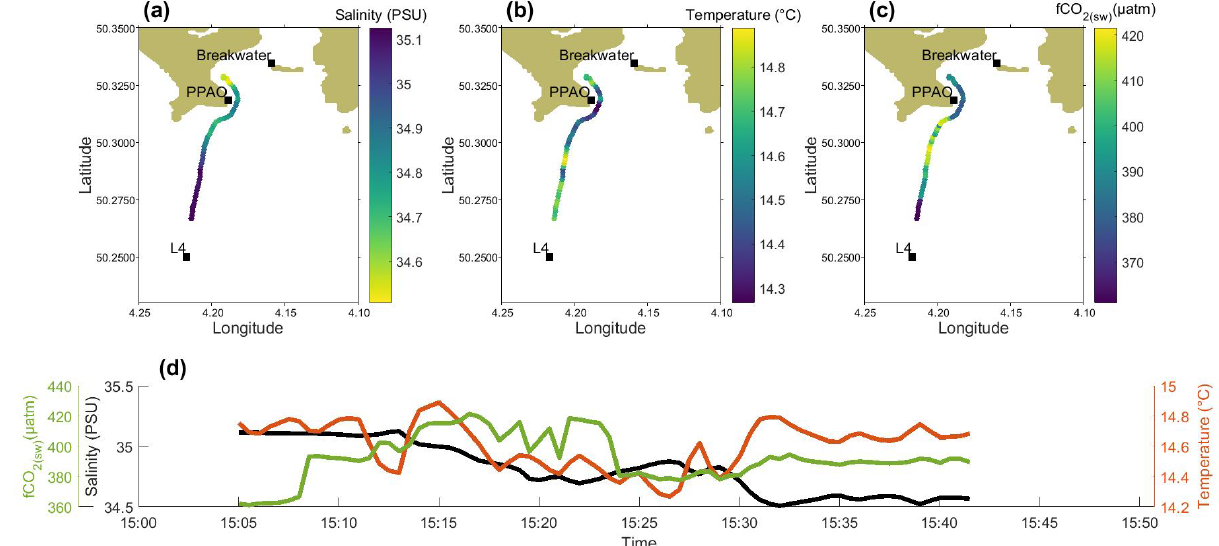
Figure 4. Example of a low water transect (transect midpoint = LW + 0.5h). Surface measurements of salinity, temperature and f CO 2 rep- resented spatially (a–c) and as a time series (d) from station L4 toward the coast. Data were collected aboard RV Plymouth Quest on 7 July 2016 (filled circles, data every 30s).